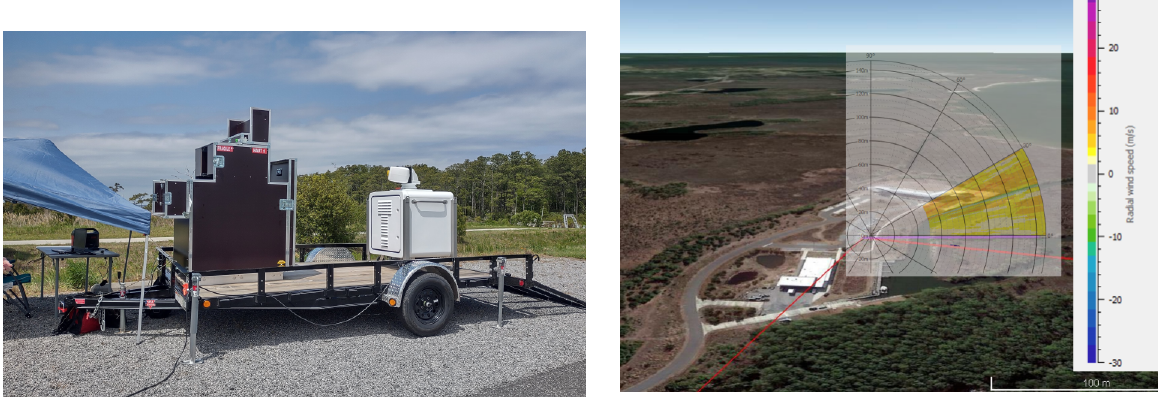
Figure 4: Windcube Scan 100s field-deployable scanning Doppler LIDAR